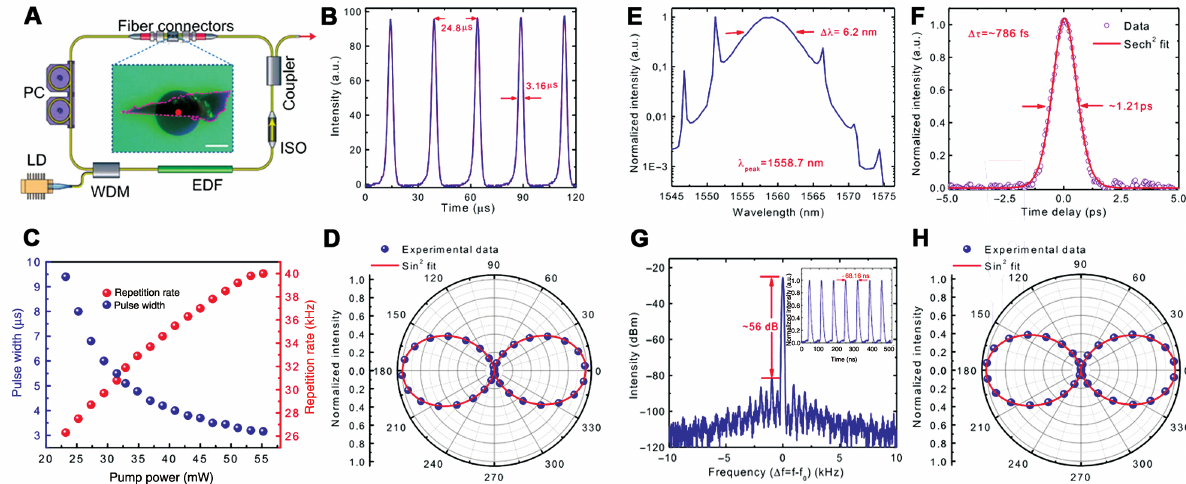
Figure 6: The linearly polarized Q-switched and mode-locked fiber lasers incorporating BP-based saturable absorber. (A) Experimental setup. (B) Q-switched pulse train. (C) The pulse duration as well as repetition rate against the pump power. (D) Output polarization property of Q-switched fiber laser. (E) Optical spectrum of mode-locked laser. (F) The corresponding autocorrelation trace and (G) RF spectrum. (H) Output polarization property of mode-locked fiber laser. Reproduced with permission from Li et al.